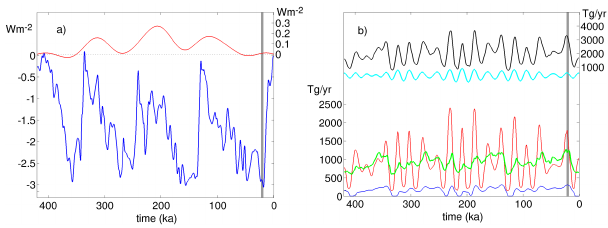
Figure 1. Forcing time series of climate model in Wm − 2 (a) and simulated dust emission flux in Tgyr − 1 (b) for the past 420kyr. (a) Annual global mean radiative forcing relative to present day from equivalent CO 2 concentration (blue line) and orbitally varying in- solation (red line). (b) Global dust emission flux of the total (black line) and of partitions from deserts (red line), grass areas (green line) and exposed shelf areas (blue line) compared to climatic pre- cession parameter in arbitrary units (cyan line). Vertical grey bars mark LGM period over